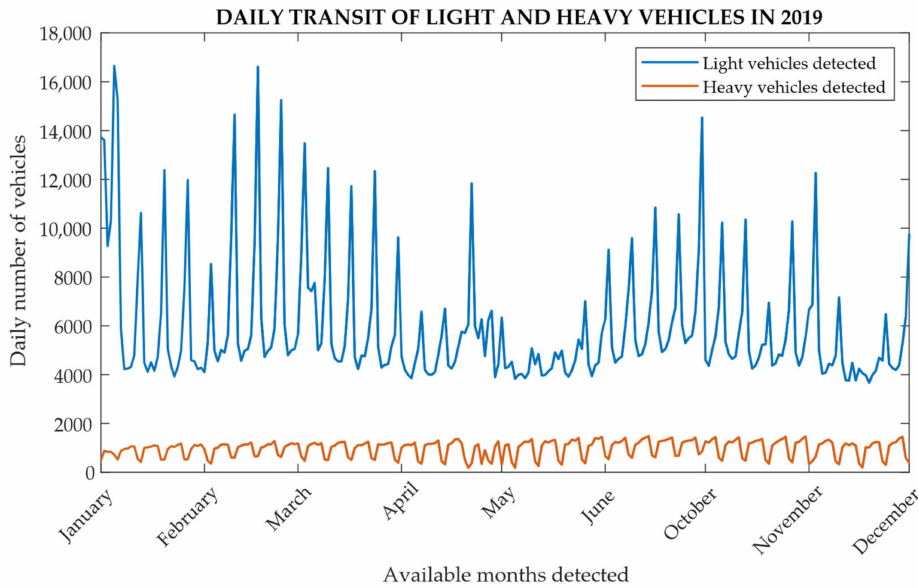
Figure 21. Data of the daily transit of light and heavy vehicles between October and June recorded in 2019 in the highway section of the case study